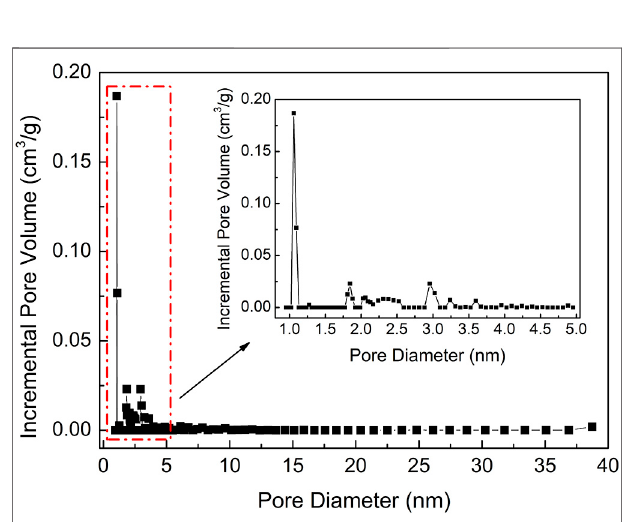
FIGURE 3 | Pore size distributions of WIRAC by the DFT